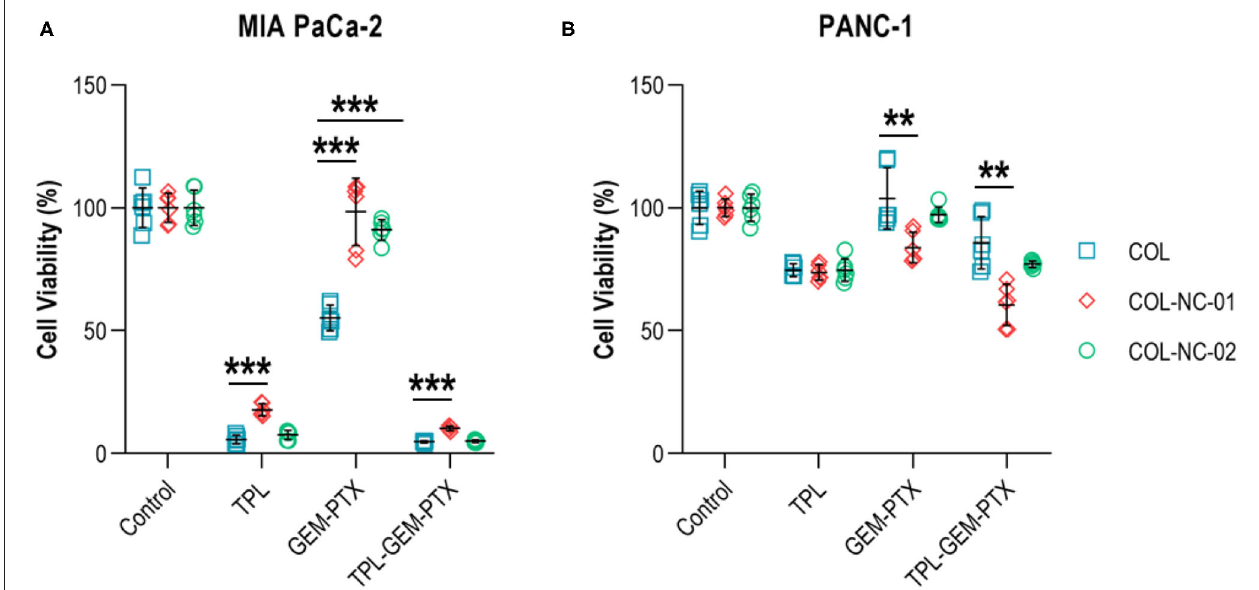
FIGURE 4 | Treatment of tumour spheroids. (A) The viability of MIA PaCa-2 cells was reduced about 85% upon treatment with triptolide in the collagen matrix, whereas the treatment with gemcitabine and paclitaxel reduced cell viability by nearly 50%. (B) The viability of PANC-1 cells grown in collagen and collagen-nanocellulose matrices was decreased by 30% when exposed to triptolide, while the treatment with gemcitabine and paclitaxel did not have significant cytotoxic effects. Cells were treated with triptolide for 3 days, followed by gemcitabine and paclitaxel for 4 days. Results shown represent independent experiments performed in triplicates ( n = 3, error bars = SD; ** = p ≤ 0.01; *** = p ≤ 0.001). COL, collagen; NC, nanocellulose; COL-NC-01, collagen-nanocellulose at 0.1 wt%; COL-NC-02, collagen-nanocellulose at 0.2 wt%; TPL, triptolide; GEM-PTX, gemcitabine-paclitaxel, TPL-GEM-PTX,